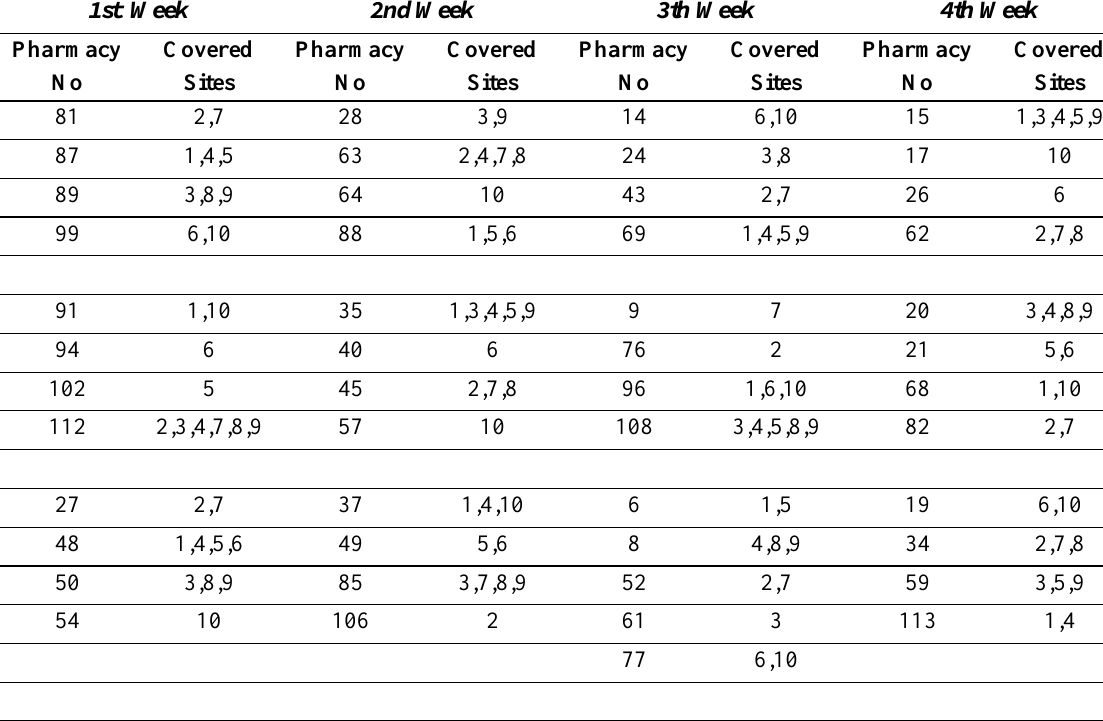
Table 1. W eekly representation of covered sites by duty